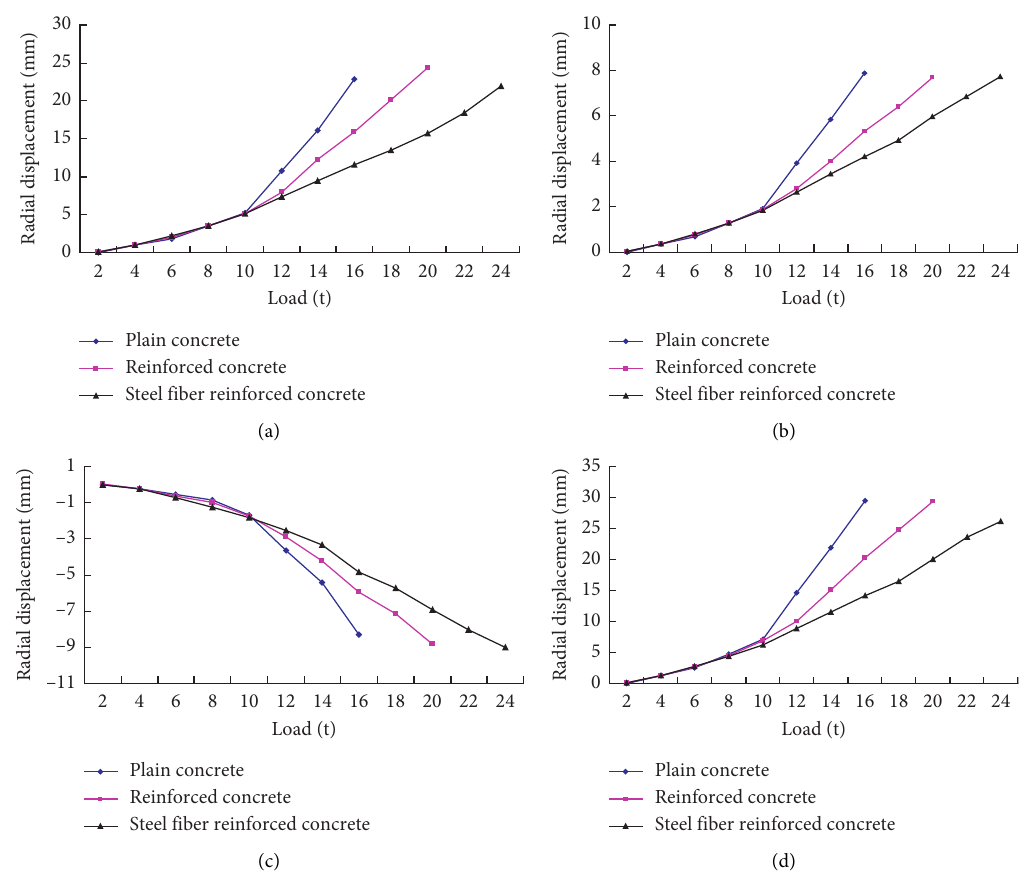
Figure 15: Change of radial displacement with a load. (a) Measuring point 1 (vault). (b) Measuring point 2 (haunch). (c) Measuring point 1 (middle of the side wall). (d) Measuring point 1 (middle of the inverted